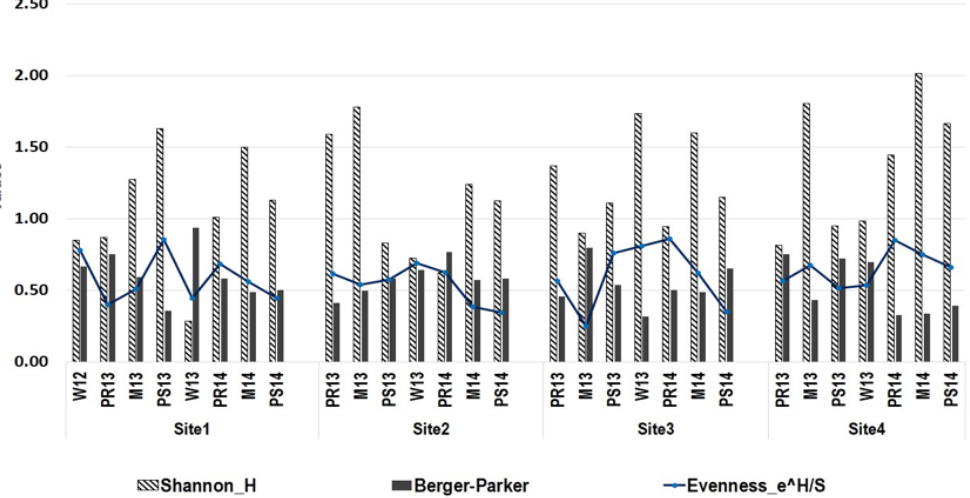
Figure 5. Spatial and temporal variation in Shannon Weiner diversity index, Evenness index, and Berger-Parker index of dominance in the four Sites of Sonebeel (W12 = winter2012; PR13 = Premonsoon2013; M13 = Monsoon2013; PS13 = Postmonsoon2013; W13 = Winter2013; PR14 = Premonsoon2014; M14 = Monsoon2014; PR14 = Postmonsoon 2014)